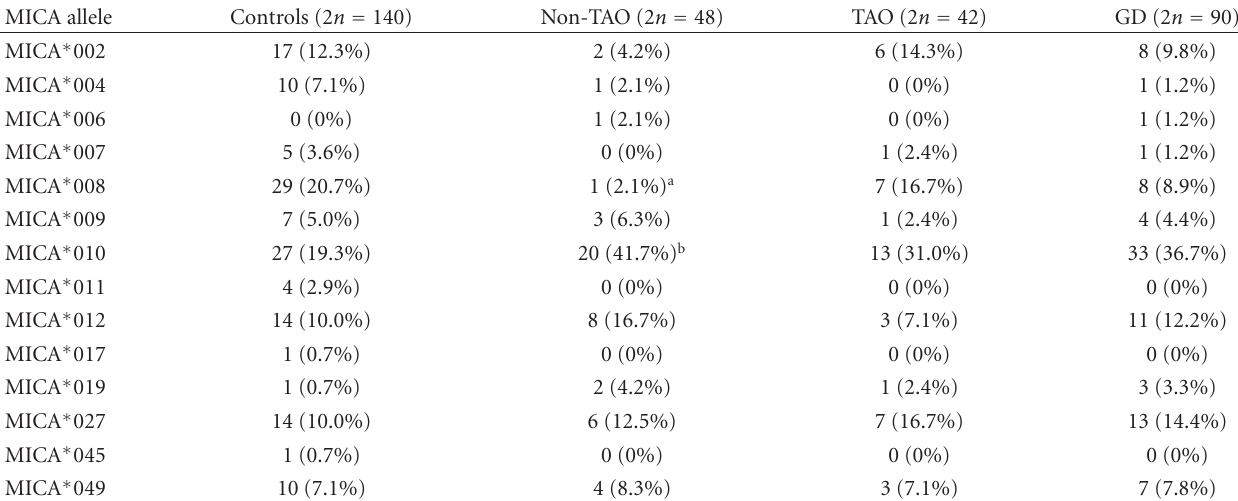
Table 2: Allele frequencies of MICA in patients with GD with and without TAO.